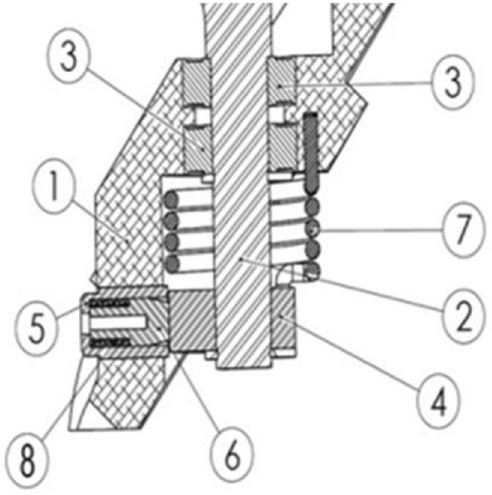
Figure 2. Cross sectional view of the mechanism and components